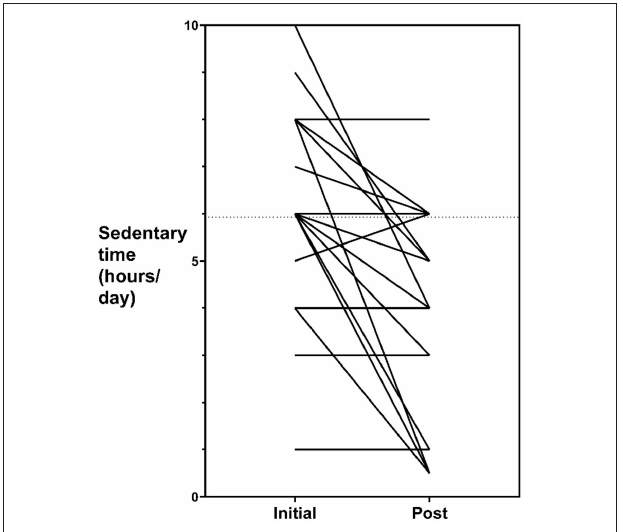
FIGURE 2 | Sedentary time pre- and